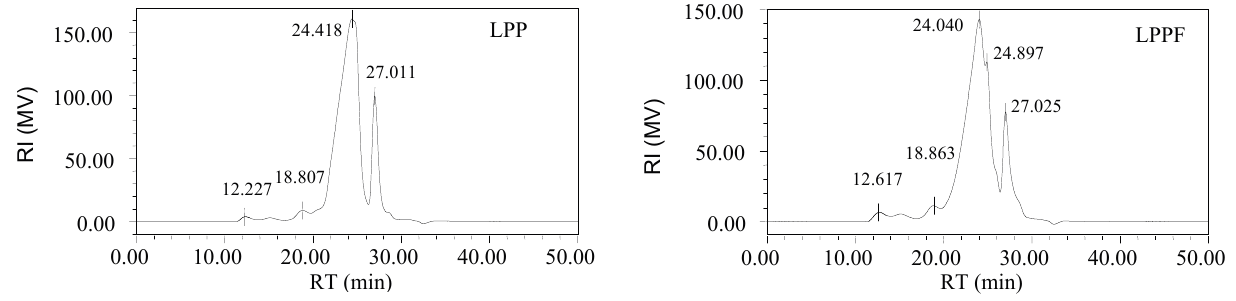
Figure 1. Gel filtration chromatograms of crude longan polysaccharide-protein complexes treated with ( Right ) or without ( Left ) Fluorescein isothiocyanate (FITC).